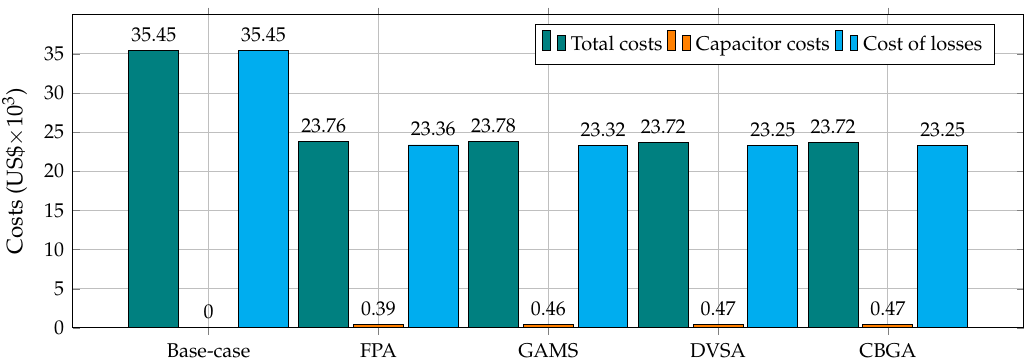
Figure 11. Discriminated costs for the 33-node test feeder.